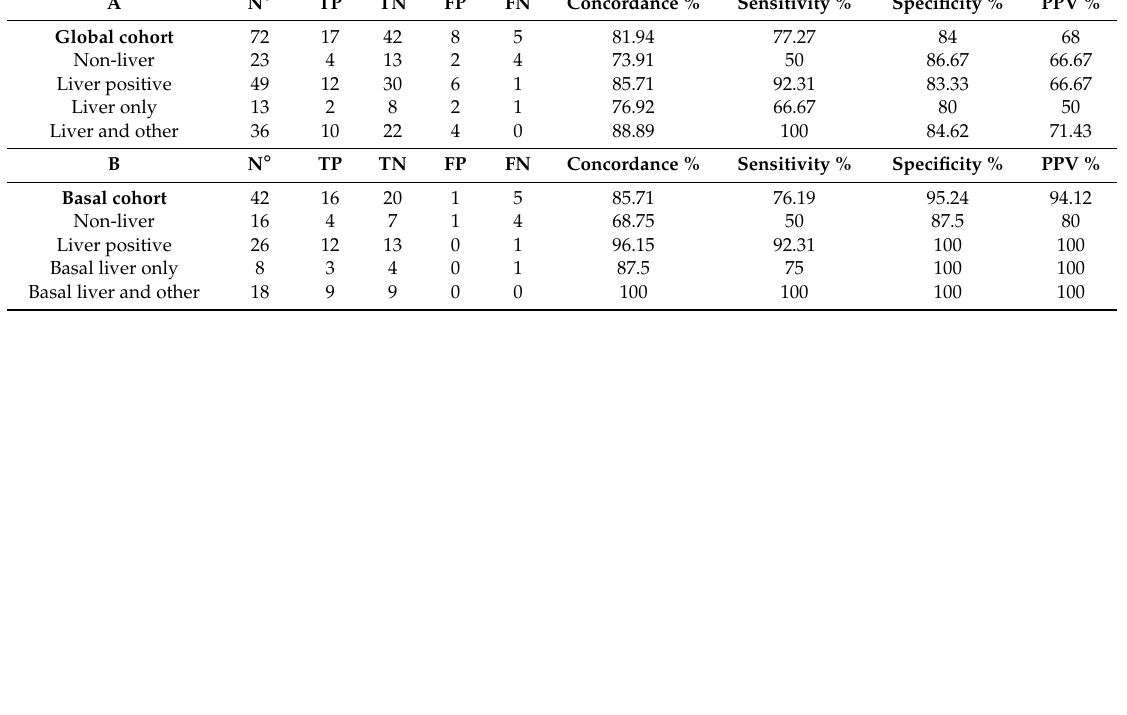
Table 1. Concordance, sensitivity, specificity and positive predictive value according to patients’ cohort. (A) GLOBAL COHORT; (B) BASAL COHORT. NON-LIVER: patients with no evidence of liver metastases; LIVER ONLY: patients with metastases limited to the liver; LIVER and OTHER: patients with metastases not limited to the liver; LIVER POSITIVE: all the patients with liver metastases (the sum of LIVER ONLY and LIVER and OTHER); TP: true positive; TN: true negative; FP: false positive; FN: false negative; PPV: positive predictive value.